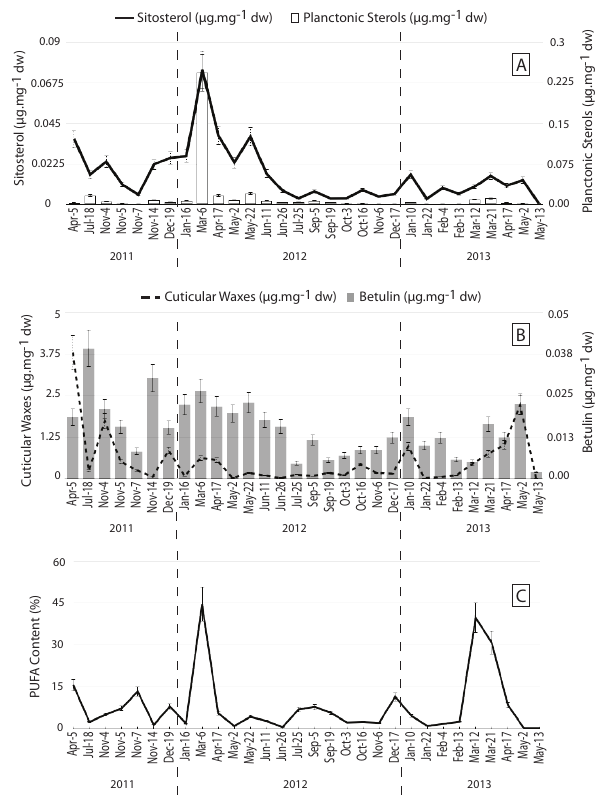
Figure 3. Sitosterol and planktonic sterols (a) , cuticular waxes and betulin (b) and poly-unsaturated fatty acid (PUFA) (c) contents of the different samples. Standard error shown was estimated to be 14% (see Sect. 2.3). Phytoplanktonic blooms are evidenced by the spike in planktonic sterols, and while the other tracers show the terrigenous origin of the POM sampled, the ubiquitous nature of sitosterol is made